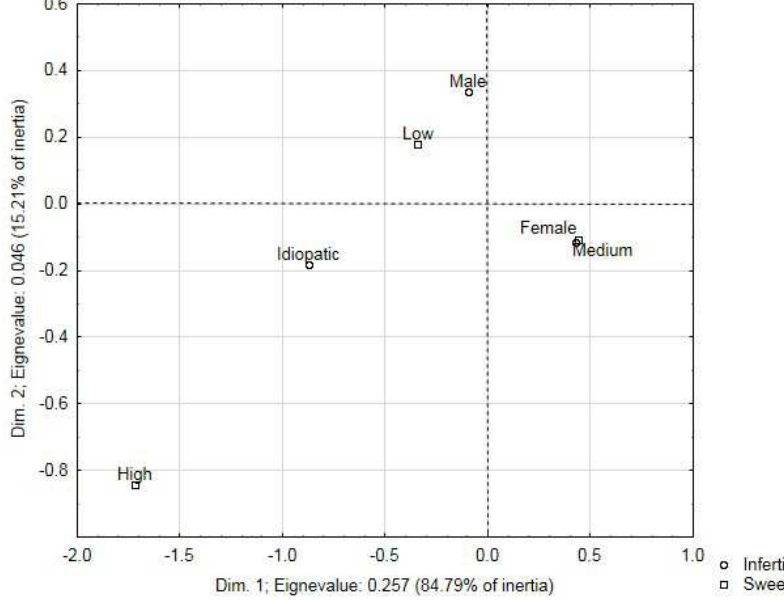
Figure 3. Correspondence map: cause of infertility vs. consumption of